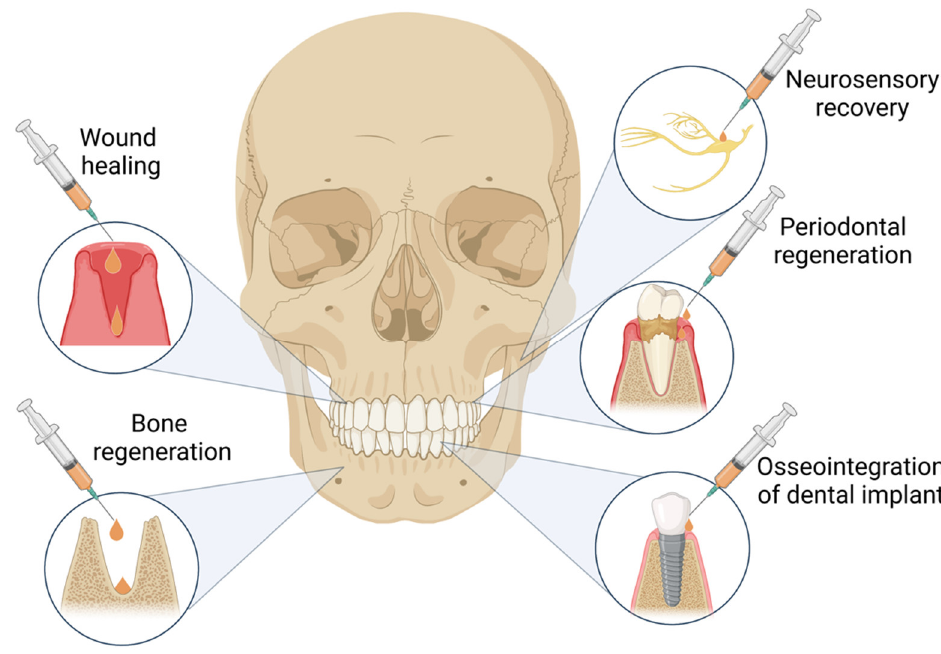
Figure 1. PRF application in oral and maxillofacial surgery. Figure created with Biorender.com.